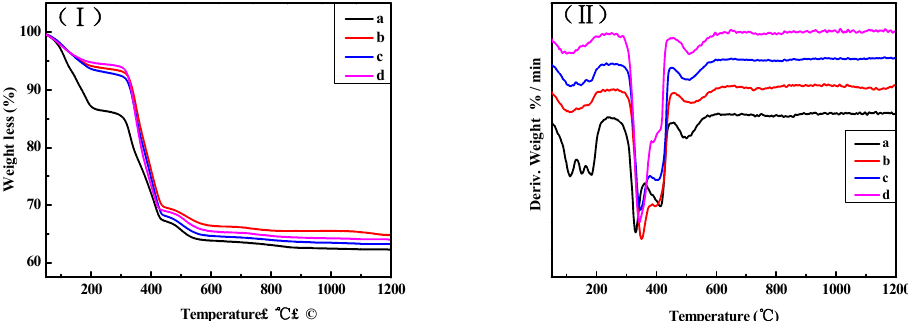
Figure 12. TG curves ( I ) and DTG curves ( II ) of the surface layers of the MOC samples after different dry–wet cycles: (a) without dry–wet cycles; (b) one time; (c) two times; (d) three times. The TG and DTG curves of the inner cores of samples “a”, “b”, “c”, and “d” are